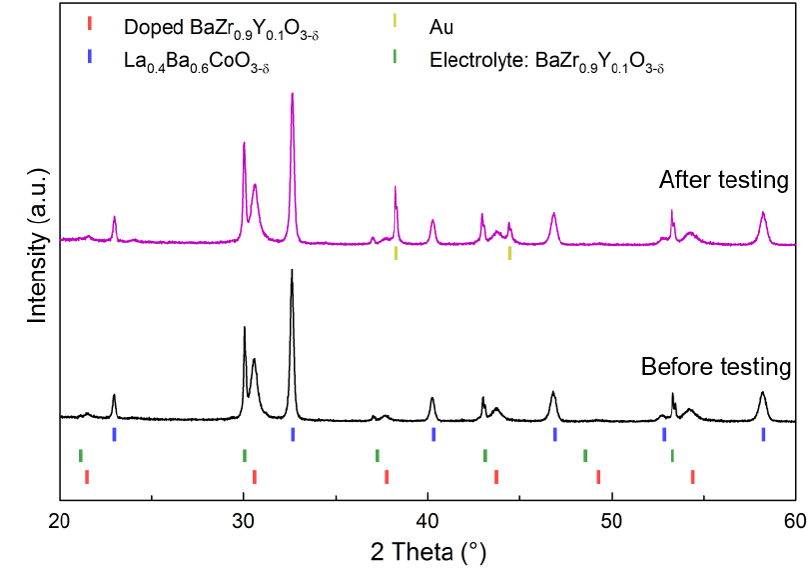
Figure 5. XRD patterns of LBZ86 composite with 0.8La 0.4 Ba 0.6 CoO 3- δ -0.2BaZr 0.9- Y 0.1 O 2.95 nominal composition. The black XRD pattern represents the composite cathode exsolved at 1100 °C on the electrolyte and the purple XRD pattern represents the cathode after EIS characterization in 3% moist synthetic air. Reflections from the gold current collector can be seen after the testing.